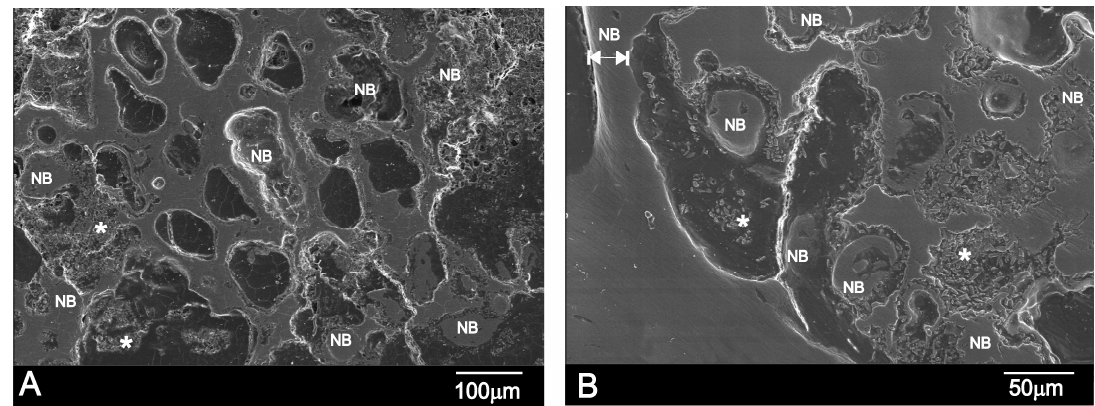
Figure 5. SEM images of the cross-section of Nurse’s A implant in bone after ( A ) 15 and ( B ) 30 days of